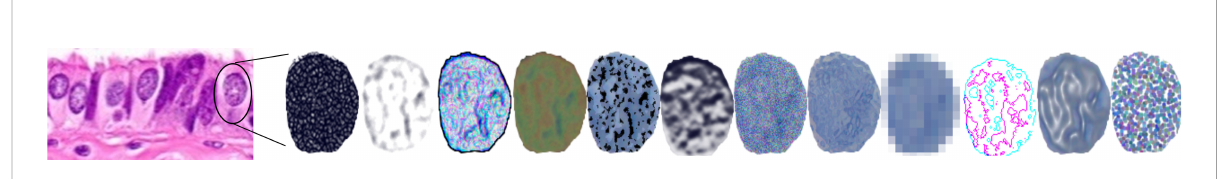
FIGURE 1 Artistic rendering of how a computer may “ see ” quanti fi able nuclear